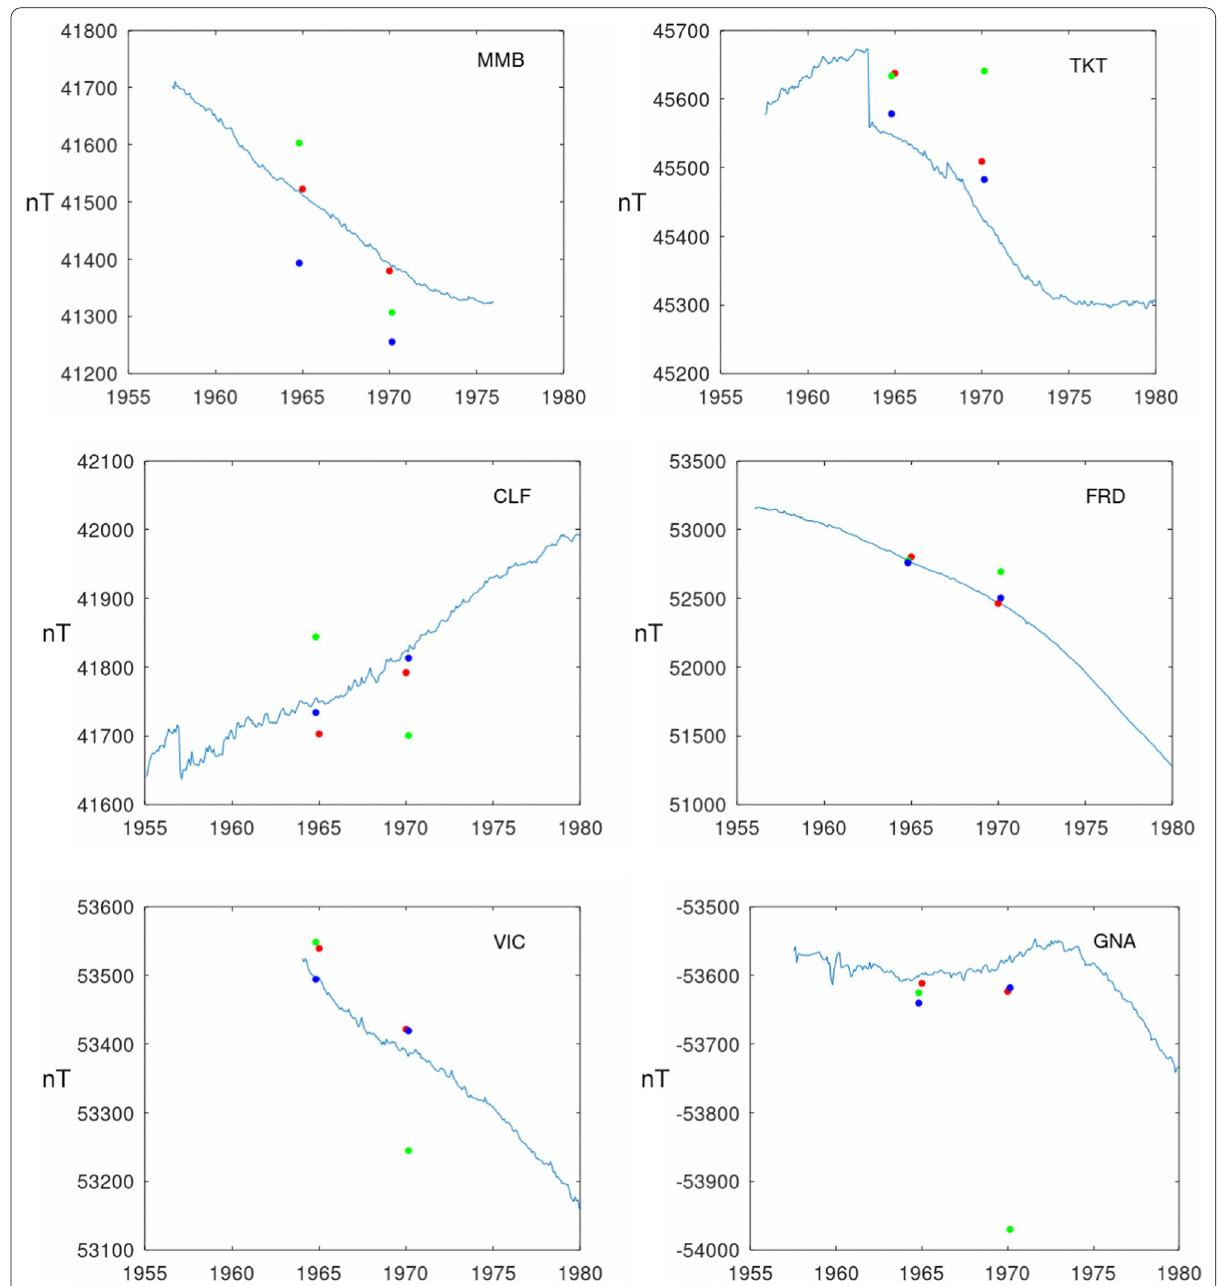
Fig. 12 Z component of the geomagnetic field measured continuously at nine magnetic observatories over 1955–1980 and predicted by different models for 1964/1965 and 1970. IAGA codes of the observatories are indicated in the upper right of each plot. The blue line shows the observatory data (monthly means), red circles show IGRF values for the beginning of 1965 and 1970, green circles show the M-1 and M-2 values and blue circles show the N-1 and N-2 values for 1964 and 1970. Data from CLF, FRD, VIC and GNA observatories are corrected for crustal biases according to (Verbanac et al.